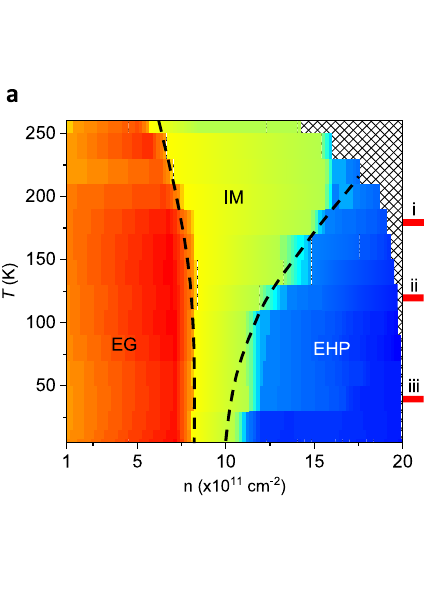
are shown in dashed lines. The shaded area indicates the inaccessible regioninthe temperatureande – hpairdensityspace. b Spectraofphaseevolutionasafunction of e – h pair densities for various T marked in a , showing the spectral features at differentphasetransition.ThedashedlinesindicatetheboundariesofEG(red)and EHP (blue) phases. Source data are provided as a Source Data fi